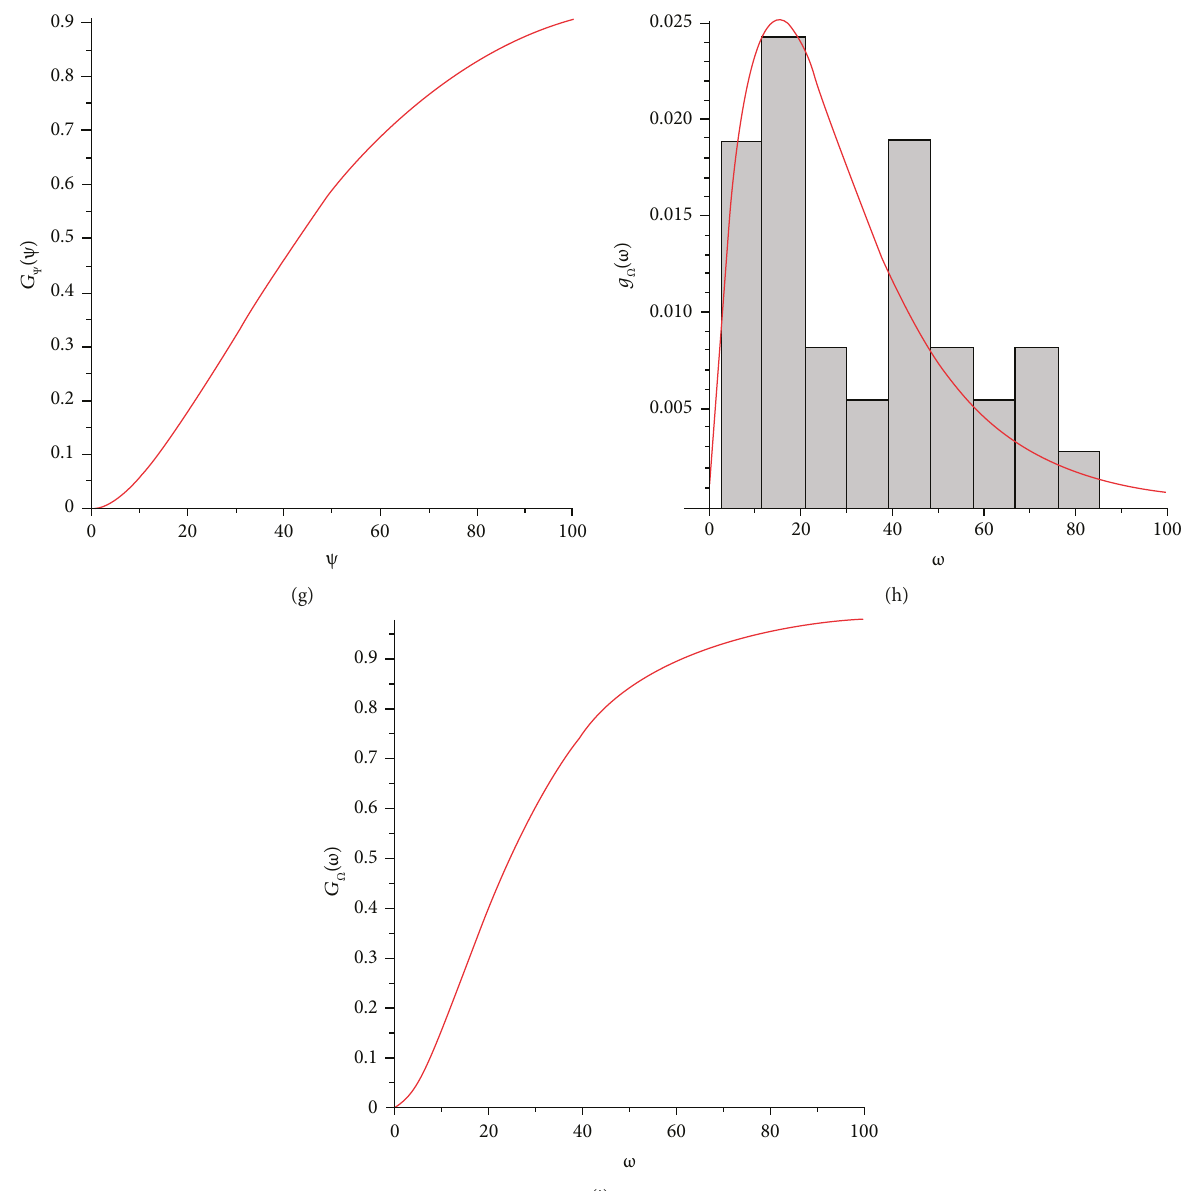
Figure 5: Statistical functions fitted for the dataset: (a) joint density function, (b) cumulative function, (c) hazard function, (d) copula function, (e) contour plot of copula function, and (f)–(i)